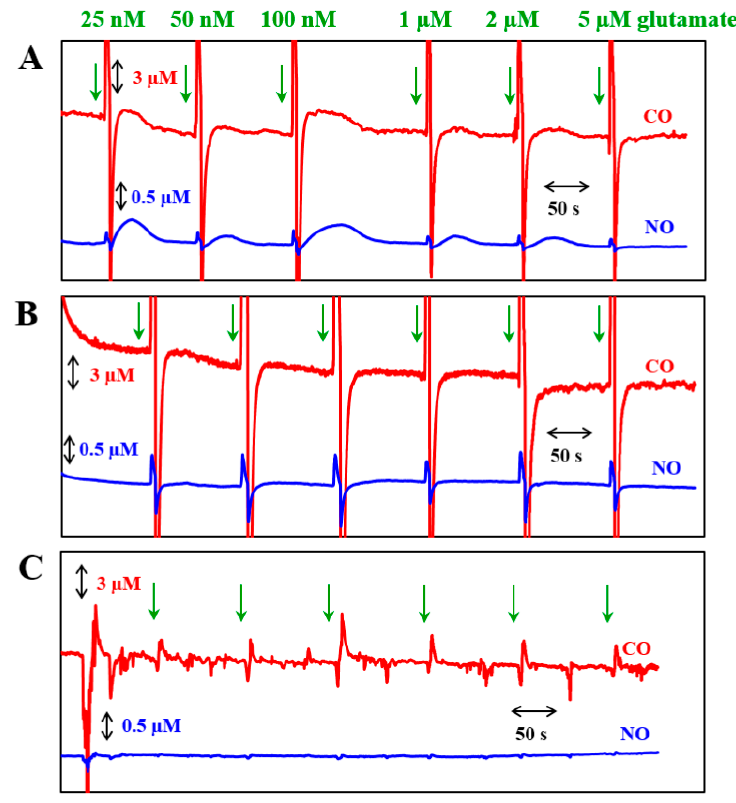
Figure 3. NO and CO concentration changes responding to sequential glutamate injections (time points are marked with green arrows), monitored for ( A ) differentiated cells, ( B ) non-differentiated cells, and ( C ) only serum-free medium with a dual NO/CO microsensor.